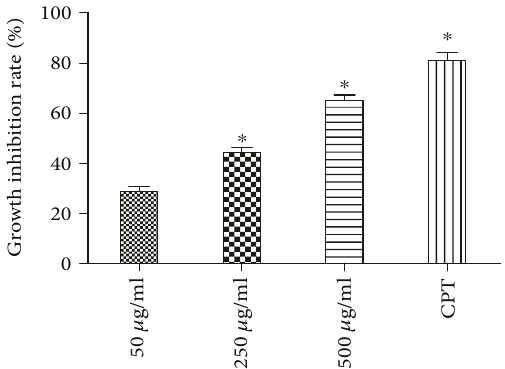
Figure 1: The growth inhibition of di ff erent concentrations of radix hedysari polysaccharide on U251 cells detected by the MTT assay. ∗ P < 0 05 , comparing the 50 μ g/ml RHPS experimental